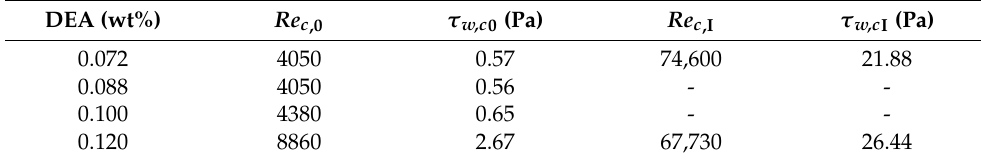
Figure 4. The effect of DEA concentration on the course of λ = f ( Re ). Table 3. Values of Re c, 0 and τ w,c 0 for different DEA concentrations (CAPB = 0.12 wt%; T = 25 ◦ C). DEA